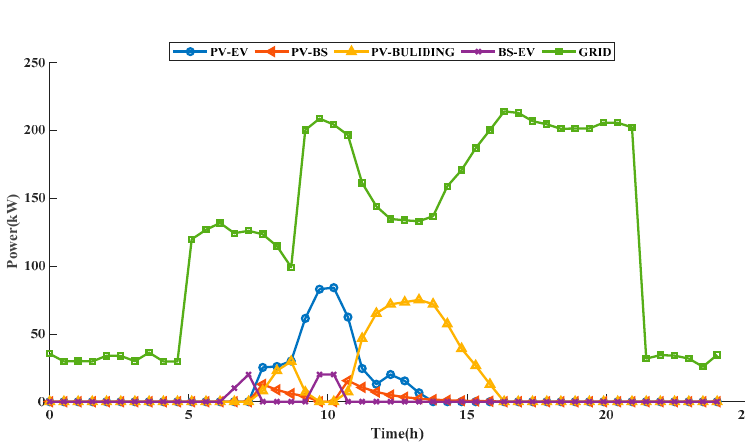
Figure 15. EPT and sell price of EV.